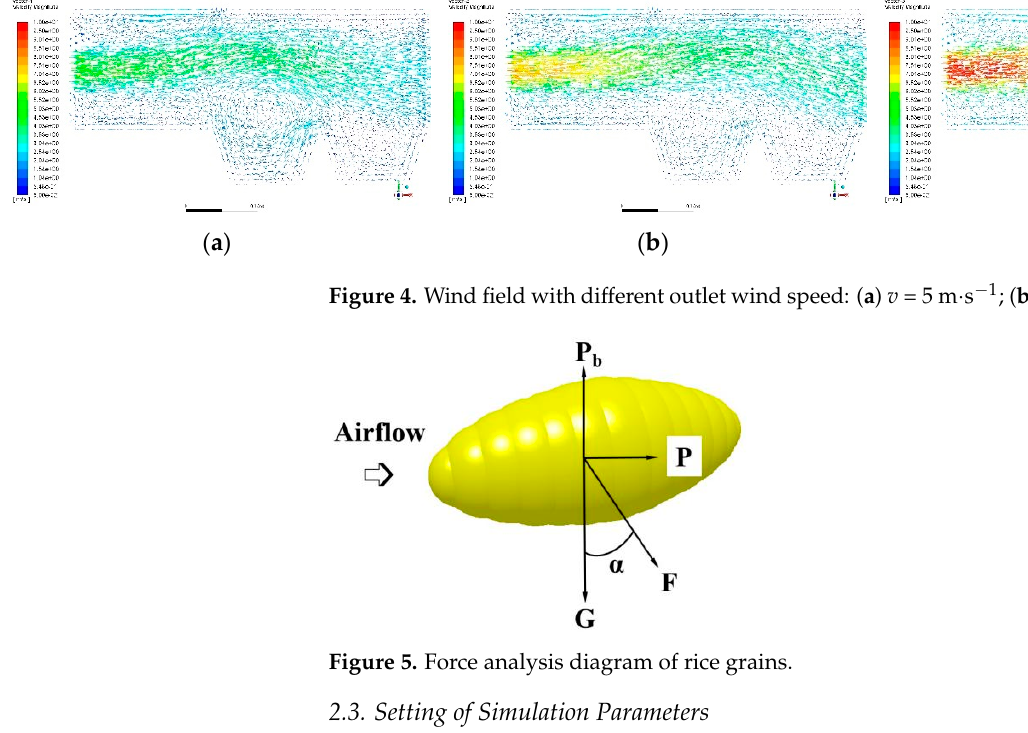
Figure 3. Rice particle simulation: ( a ) particle size; ( b ) particle model; ( c ) rice grain.